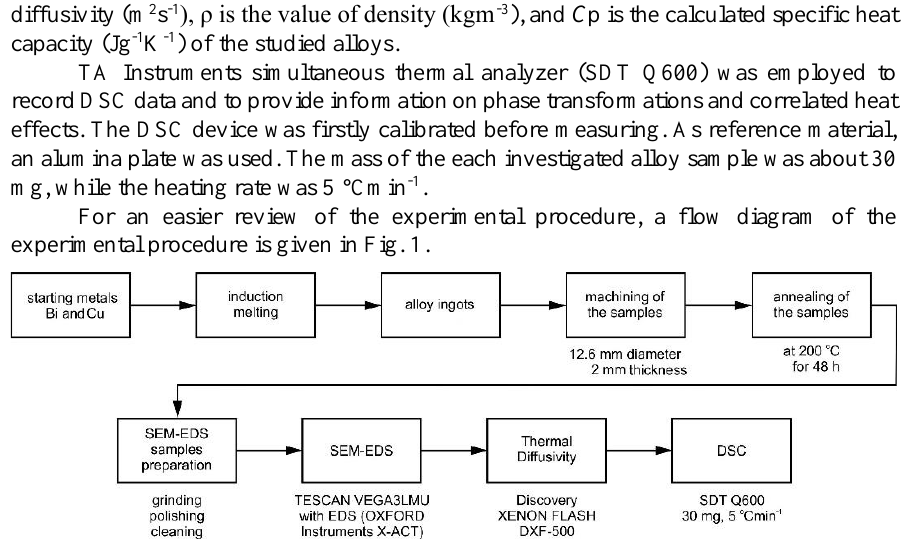
Fig. 1. Flow chart of the experimental